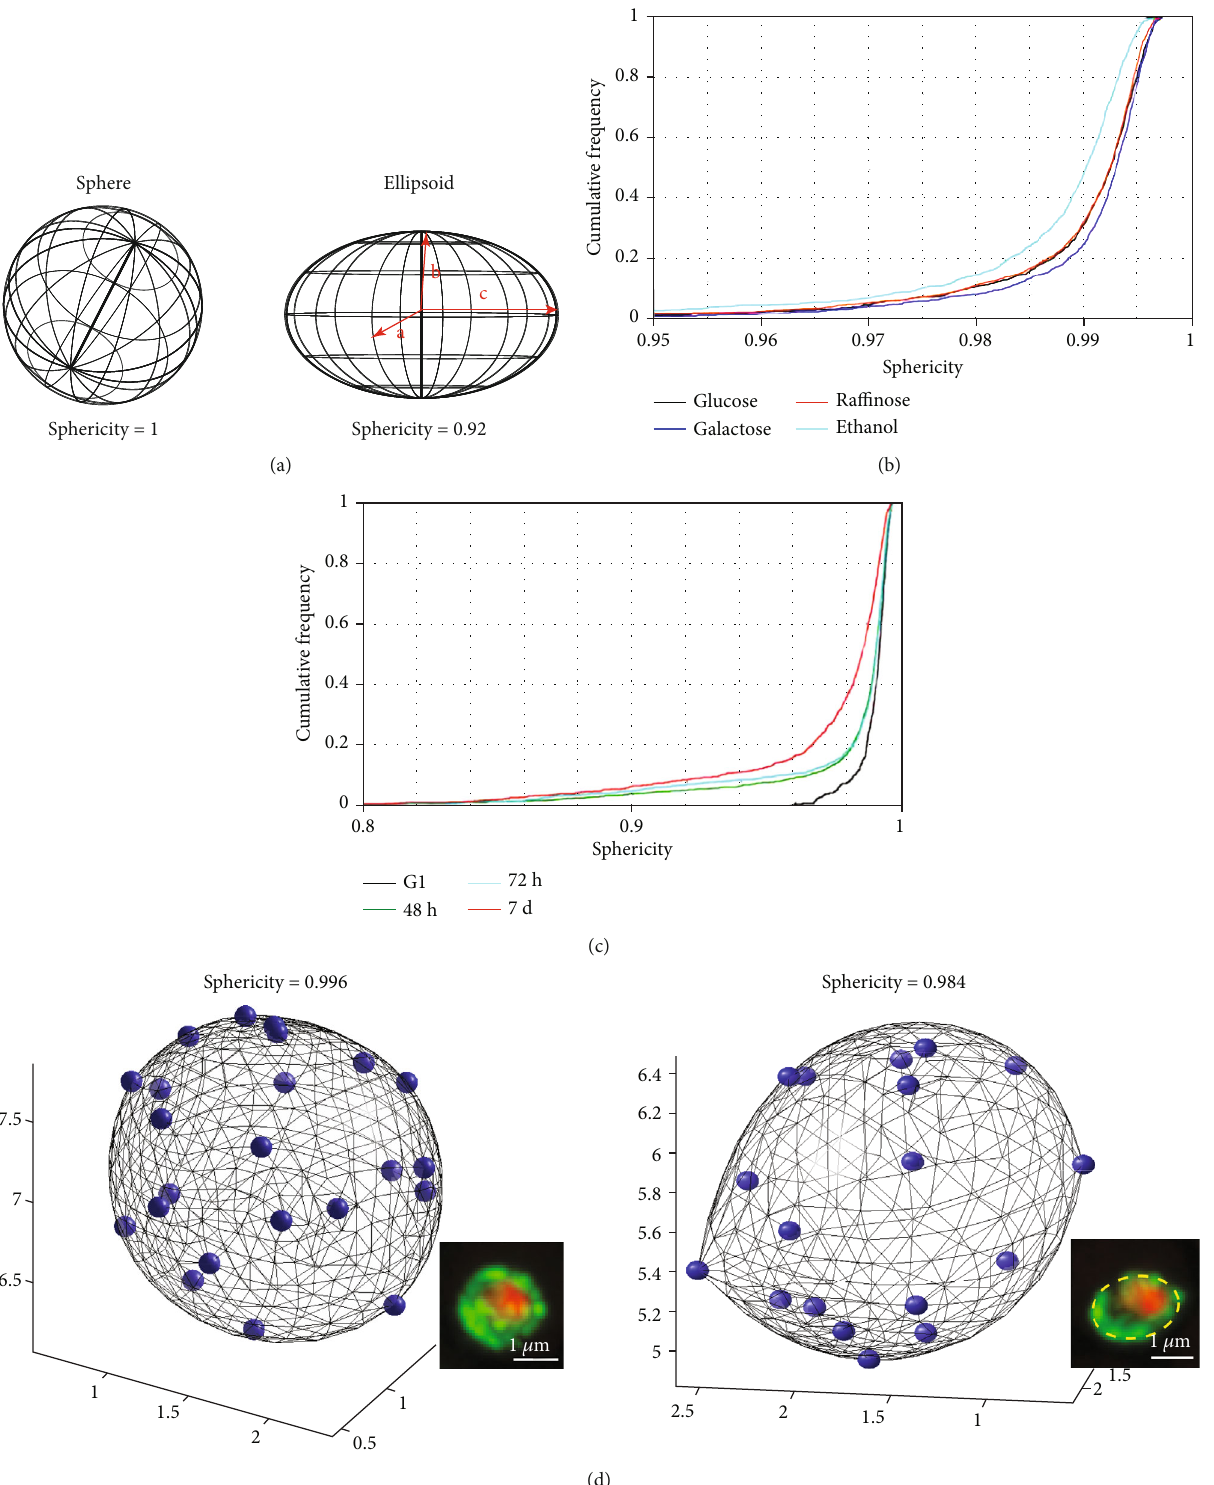
Figure 1: The heterogeneity of the nuclear shape in the cell population. (a) The sphericity of the perfect sphere ( sphericity = 1 ) and the ellipsoid ( sphericity = 0 : 92 ). (b) The change of the nuclear geometry in cell population cultured by di ff erent carbon sources, the sphericity of the nuclei decreases when the carbon source changed from the most favorable to the less favorable. (c) The distribution of the nuclear geometry after the cell population enters quiescence. (d) Two typical examples of the nucleus with di ff erent geometry in vivo , small blue spheres represent the detected NPC